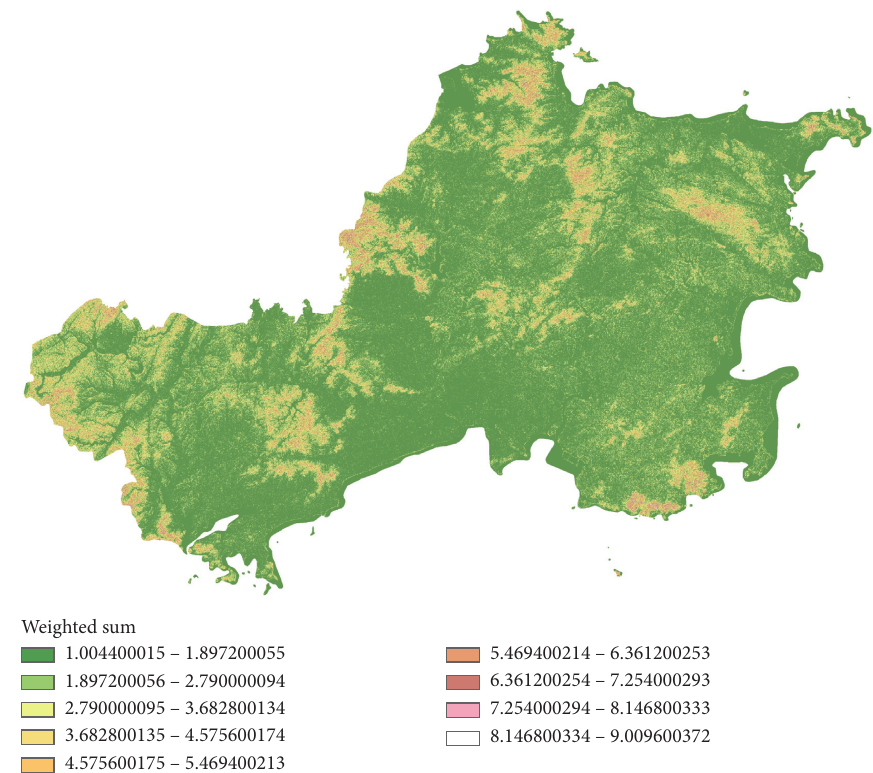
Figure 9: Cost overlay of three judgment